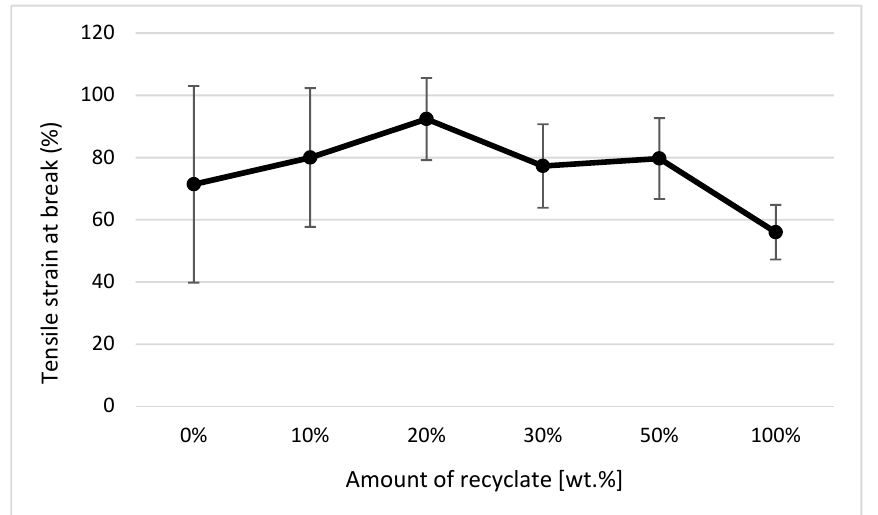
Figure 10. Dependence of the elongation at break point on the proportion of weight of the recycled material before exposing the samples to elevated temperature.